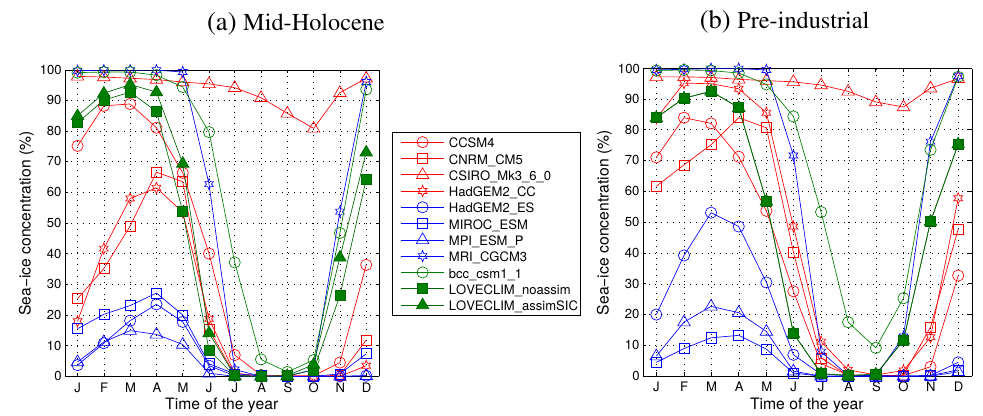
Figure 5. Mid-Holocene (6ka) and pre-industrial (AD1850–1900) mean seasonal cycles of sea ice concentration (in %) in the Barents Sea (at the location of the proxy-based reconstruction id 18).